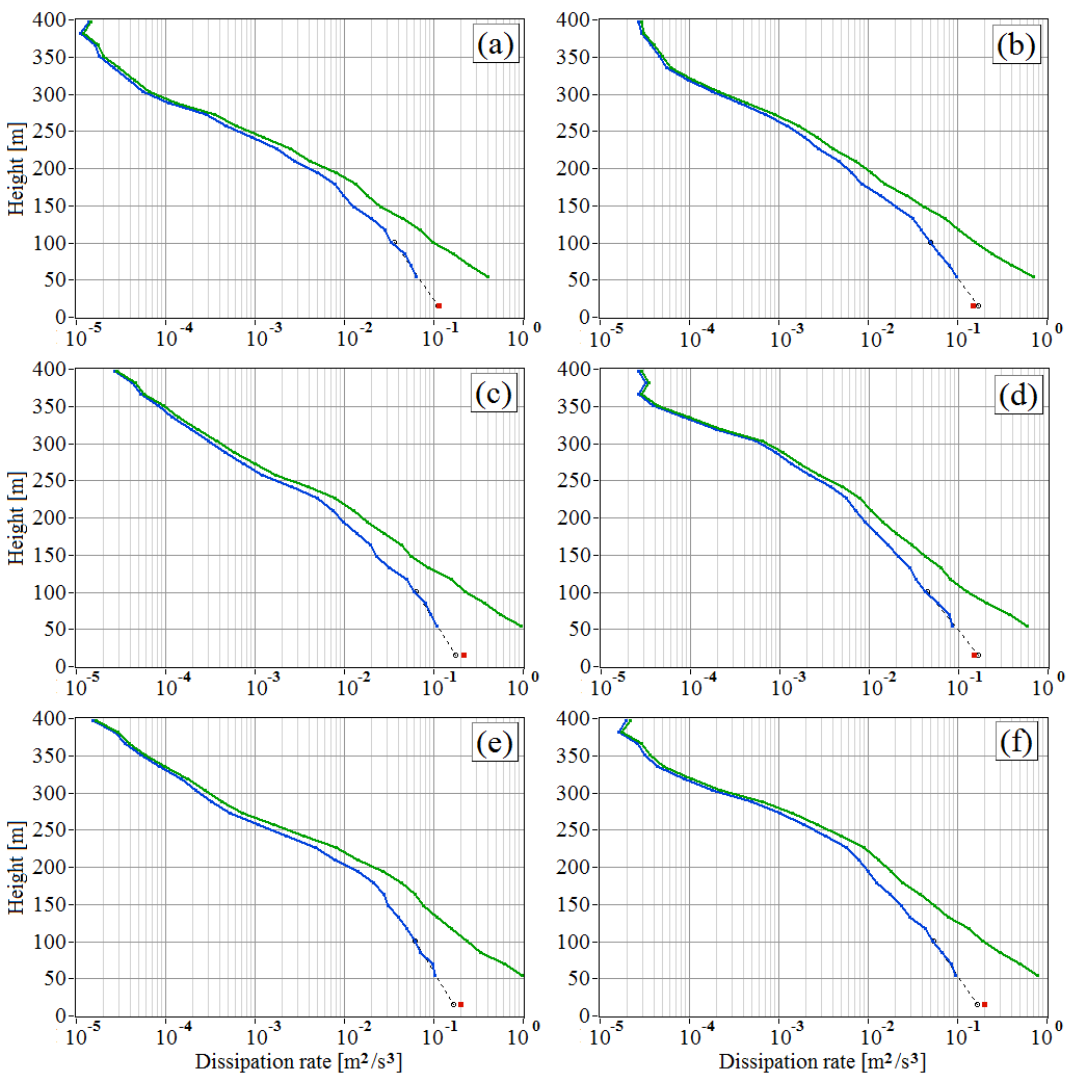
Figure 7. Vertical profiles of the turbulent energy dissipation rate at 20:30 ( a ), 21:30 ( b ), 22:30 ( c ), 23:30 ( d ) on August 19 and 00:30 ( e ) and 01:30 ( f ) on August 20, 2019, as calculated with Method 1 (green curves) and Method 2 (blue curves). The lidar data are taken from Figure 4c,d. Red squares indicate estimates of the dissipation rate from simultaneous measurements by the sonic anemometer.